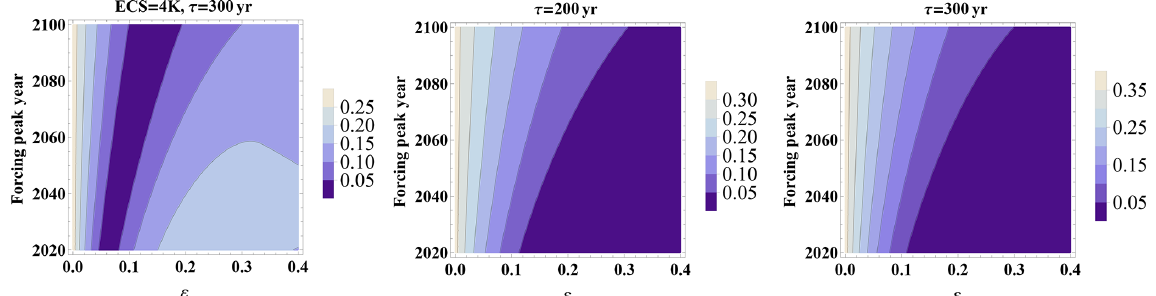
Figure 12. Similar to the previous figure (relative max. GMT error with abscissa of ε and ordinate of t 1 in years), however for a further adjusted ECS of the one-box model, such that perfect matching is achieved for t 1 = 100 years, ε = 0 . 2, and a one-box timescale of 12 years. For most of the parameter settings, the relative error is below